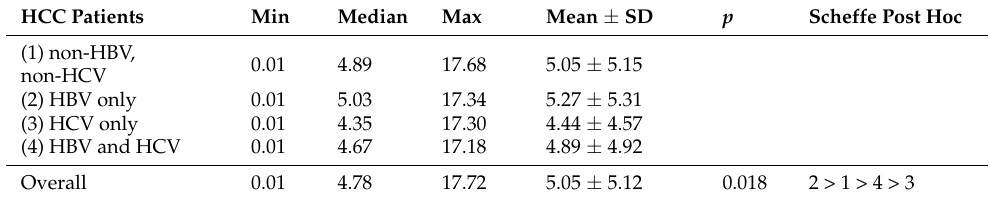
Table 3. Years to CAD.